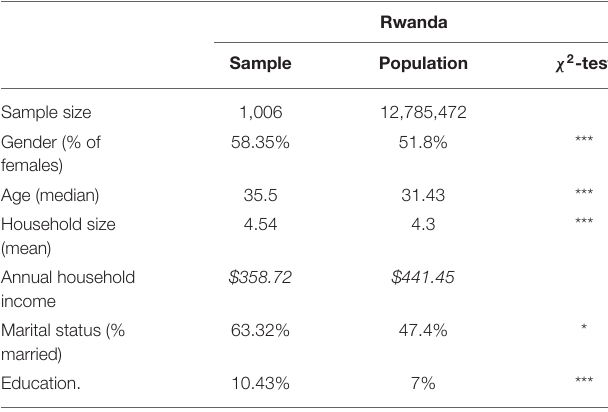
TABLE 4 | The comparison of the socio-demographic factors in the sample data and the corresponding population